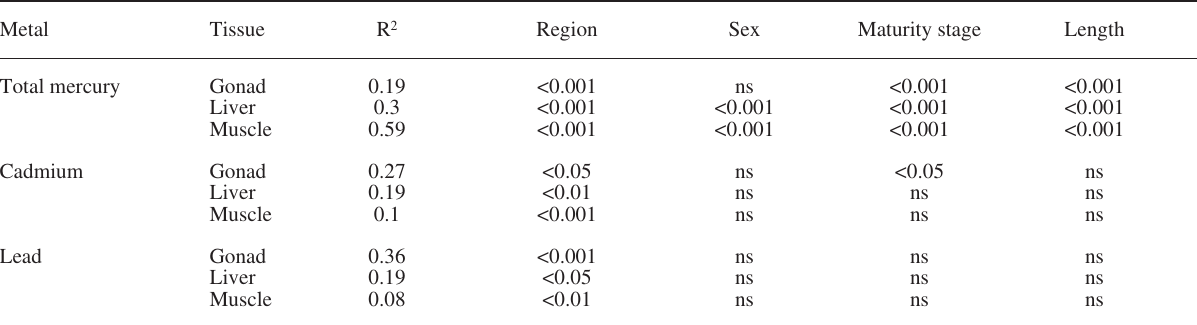
Table 3. – significance of p-values for each factor considered in linear models adjusted to total mercury, cadmium and lead levels in gonad, liver and